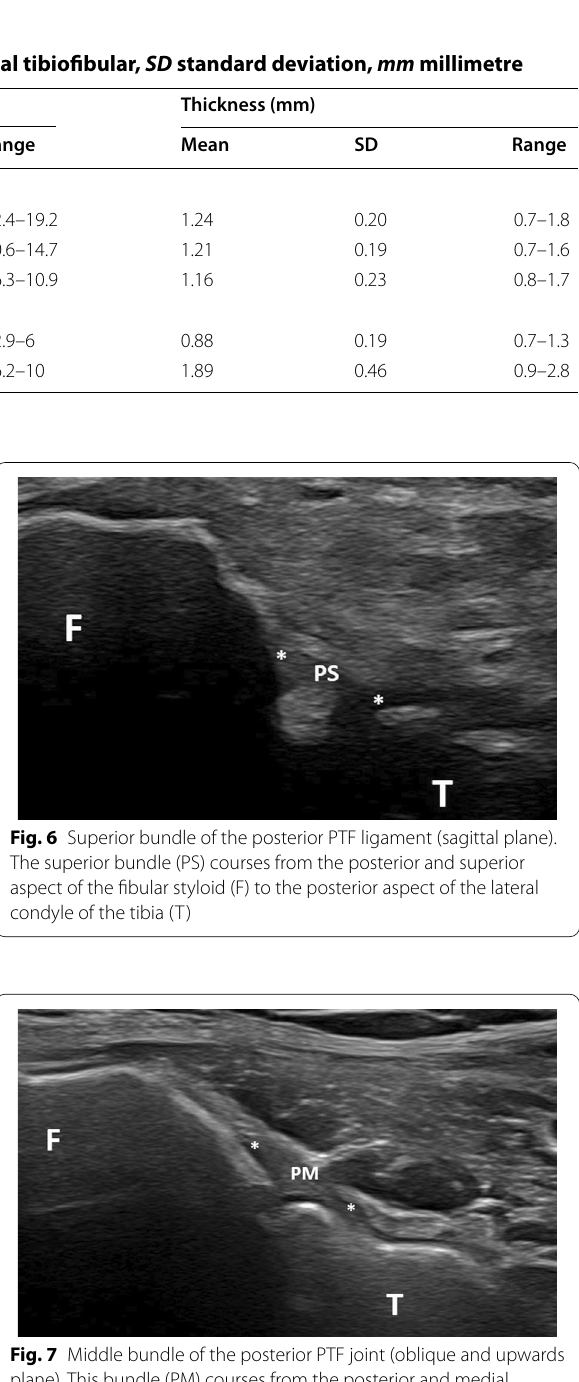
The upper middle bundle M1 could be seen in all cases as a thin hyperechoic structure extending from the anterosuperior aspect of the lateral edge of the fibu- lar head to the lateral aspect of the tibia. In contrast to our cadaveric study which showed two middle bundles in both specimens, the lower middle bundle M2 was able to be depicted on ultrasound in only 75% of the cases. Dif- ferentiation between M1 and M2 was facilitated by the depiction of a hyperechoic linear space between them,